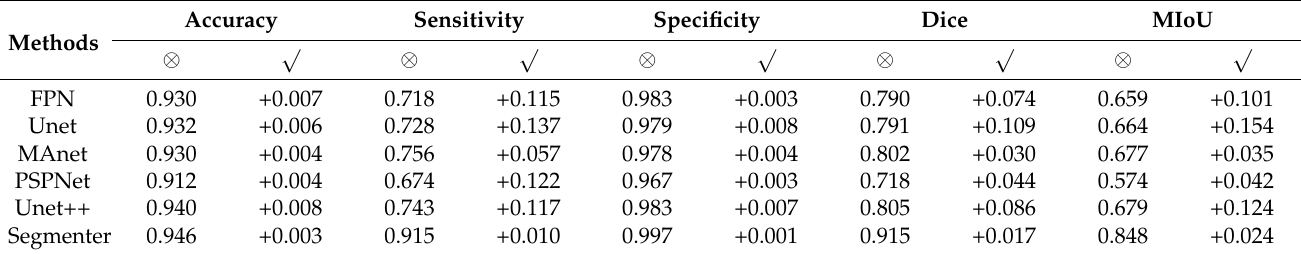
Table 3. Segmentation results of the compared methods. ⊗ : the post-processing was not used; post-processing was used; +: increase with post-processing